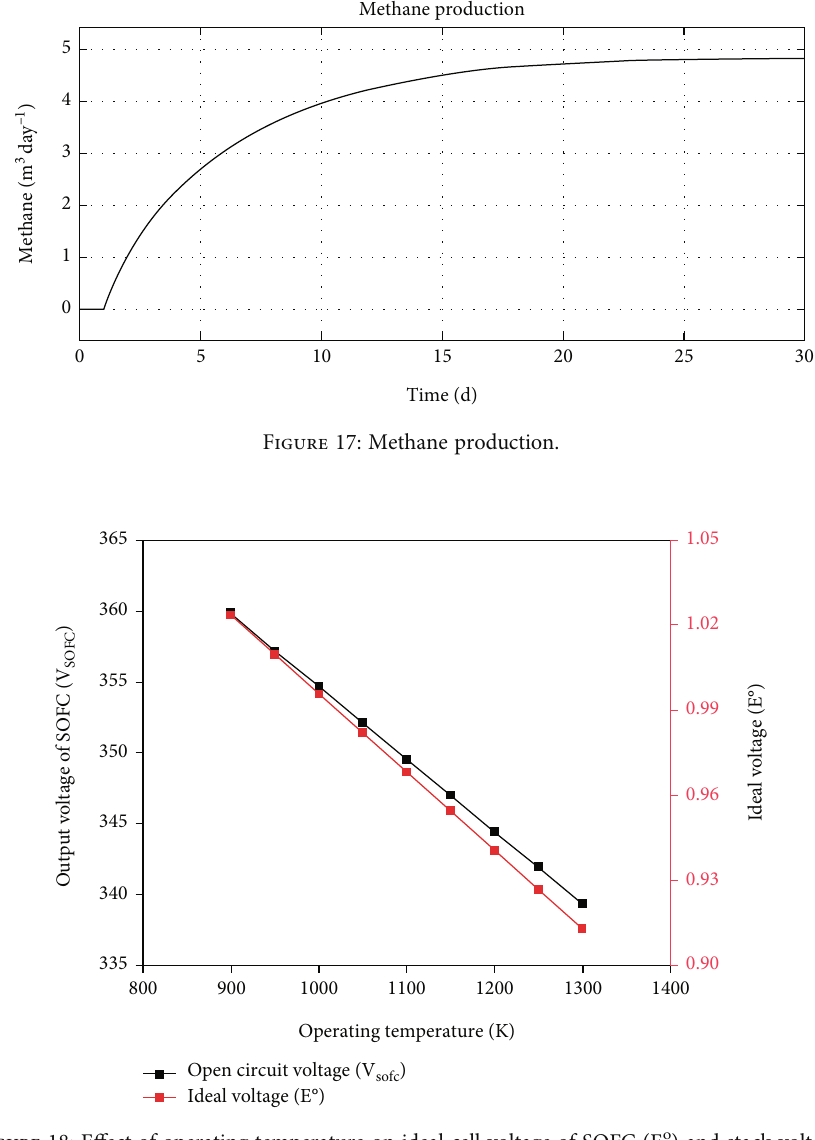
Figure 18: E ff ect of operating temperature on ideal cell voltage of SOFC (E o ) and stack